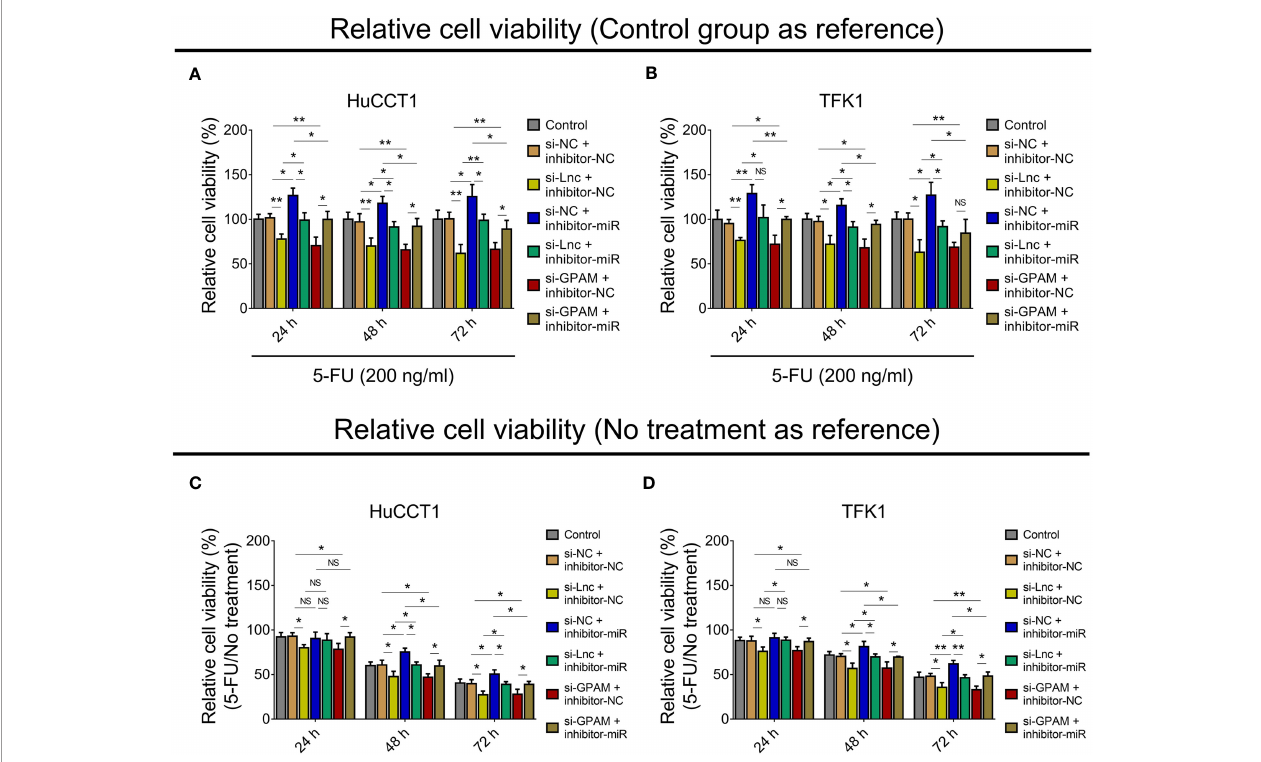
FIGURE 8 | Effect of lnc-PKD2-2-3/miR-328/GPAM network on 5-FU sensitivity in CCA cell lines. Relative cell viability (when setting control group as reference) among groups after transfection at 24, 48, and 72 h in HuCCT1 cells (A) and TFK1 cells (B) ; Relative cell viability (5-FU/No treatment) (when setting no treatment as reference) among groups after transfection at 24, 48, and 72 h in HuCCT1 cells (C) and TFK1 cells (D) . NS, not signi fi cant; * P < 0.05; ** P <